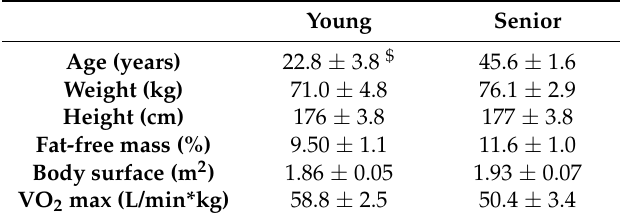
Table 1. Subject’s anthropometric characteristics and physical activity